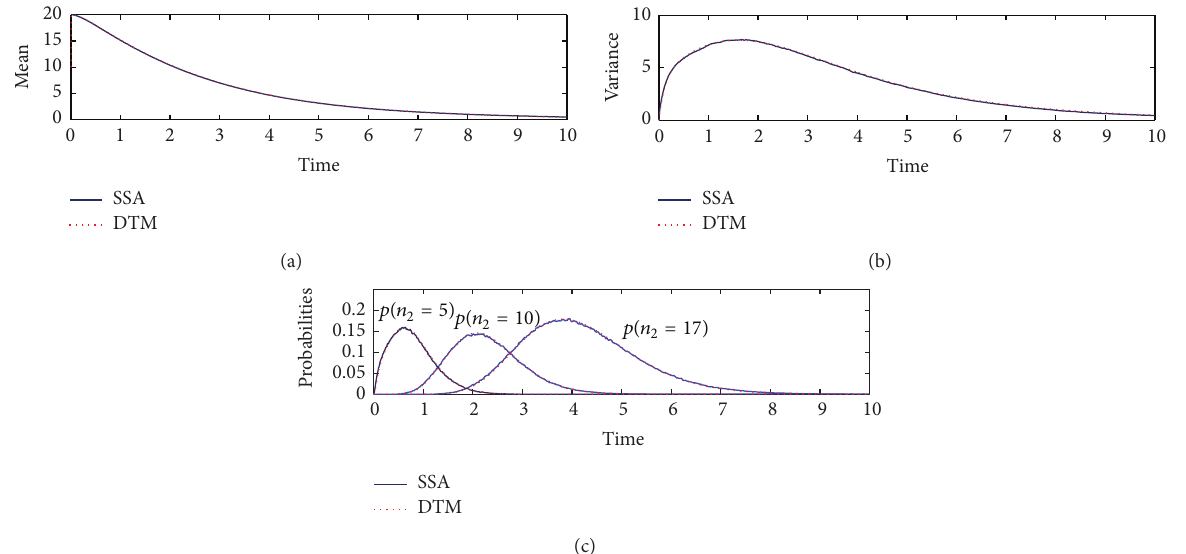
Figure 3: The initial condition 𝑛 = [10,20, 20, 0] and parameters 𝑐 1 = 0.1 , 𝑐 −1 = 1 , and 𝑐 2 = 0.5 are assumed. In (c), each curve 𝑝(𝑛 2 = 𝑖) denotes the time-dependent probability solution that 𝑛 2 = 𝑖 , 𝑖 = 5, 10, 17 , respectively. The terms which have a coefficient less than 10 −7 are dropped